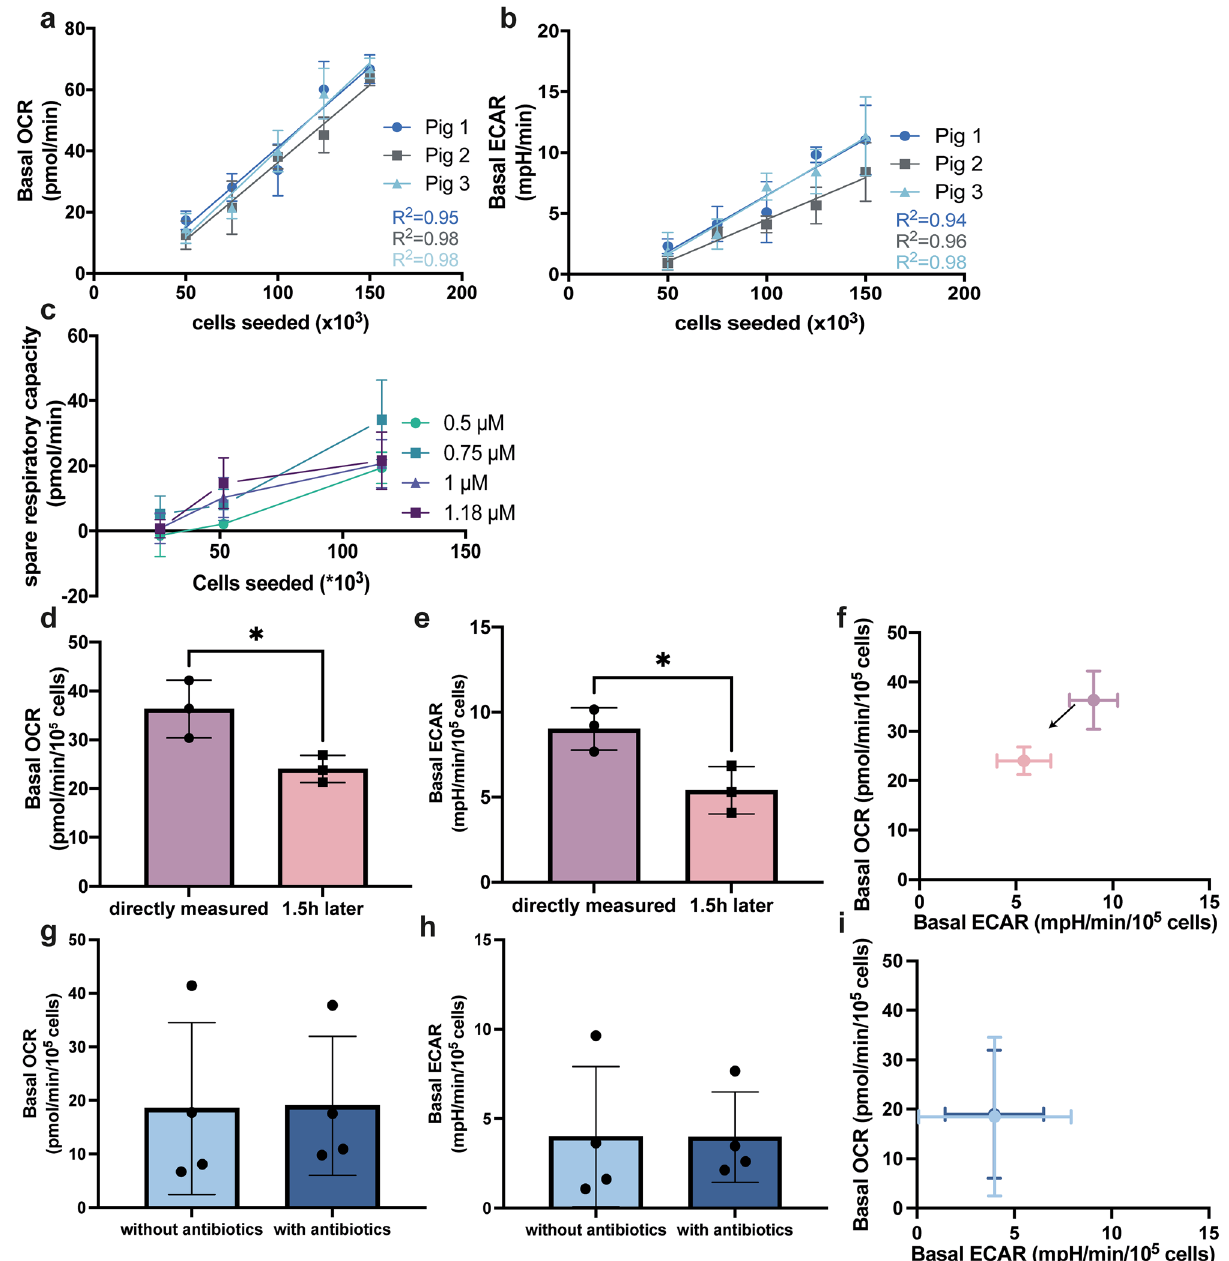
Figure 3. Optimization of Seahorse metabolic flux analysis of isolated pig IECs. ( a , b ) Comparison of the linear correlations between basal OCR and basal ECAR versus seeded cells, in a range of 50,000–150,000 cells (n = 4 wells per concentration). ( c ) Optimization of FCCP concentration for different cell concentrations, ranging from 25,000 to 115,000 cells/well (n = 3–5 wells per concentration, cells were isolated using the ‘gentle’ method). ( d – f ) Effect of leaving IECs in the plate for 1.5 h on their basal OCR, basal ECAR and energetic phenotype (n = 3 pigs). ( g – i ) Effect of addition of antibiotics to the isolation buffers and assay medium of IECs on their basal OCR, basal ECAR and energetic phenotype (n = 4 pigs with and n = 4 pigs without antibiotics). One-way ANOVA was performed to identify the optimal FCCP concentration, while student’s t-tests were performed to compare OCR and ECAR after leaving cells in the plate for 1.5 h and the effect of antibiotics, *indicates a p -value of ≤